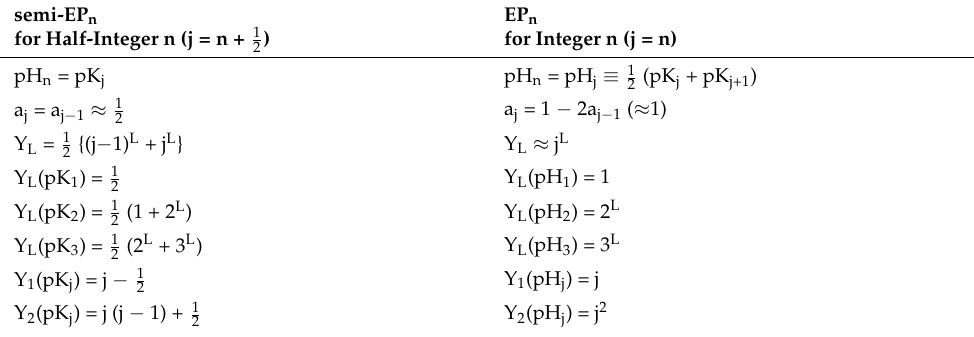
Table A1. Special values of a j and Y L at equivalence